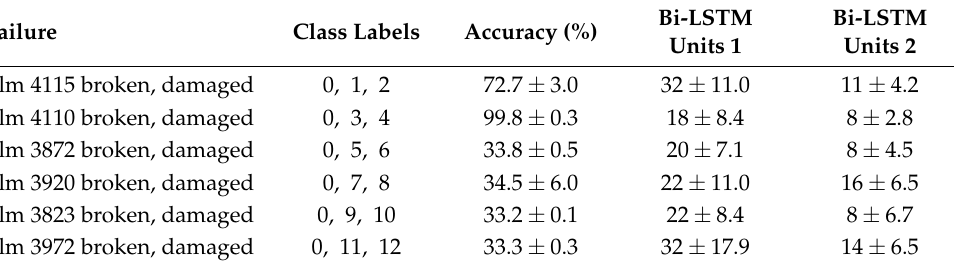
Table 5. Classification Results of the 3-class Structural Health Recognition